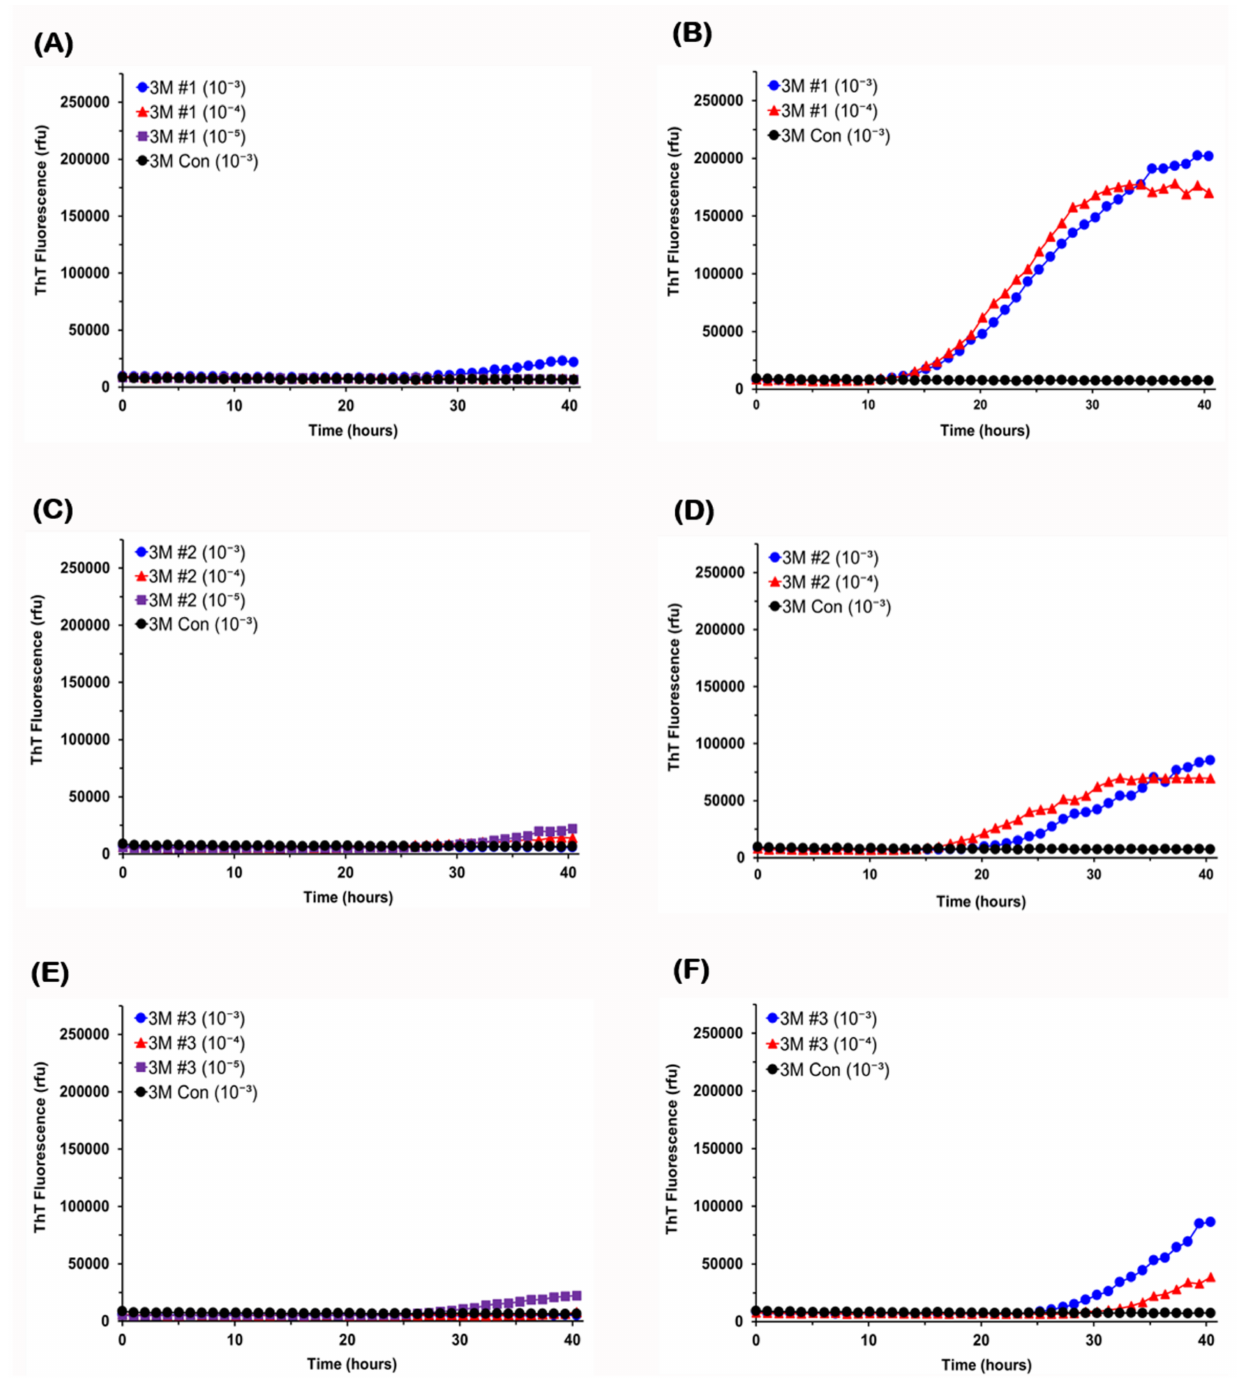
Figure 3. Alpha-synuclein seeding activity is present in the colon but absent in the brain of 3-month-old G2-3 mice. Serial dilutions of brain homogenates (10 − 3 to 10 − 5 ) or colon homogenates (10 − 3 to 10 − 4 ) from 3-month-old G2-3 mice were used to seed RT-QuIC reactions with A53T recombinant α -syn as substrate. RT-QuIC responses to brain samples were shown in the left column ( A , C , E ) and those to colon samples were shown in the right column ( B , D , F ). As controls, reactions were also seeded with 10 − 3 dilution of brain tissue or colon tissue from a non-carrier mouse of the same age. ThT fluorescence was measured at one-hour intervals and average values from quadruplicate wells were plotted as a function of